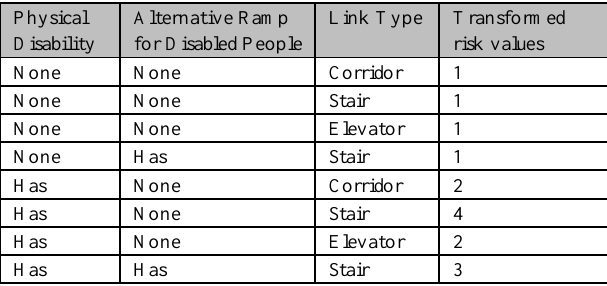
Table 4. Numerical demonstration of triple risk values.